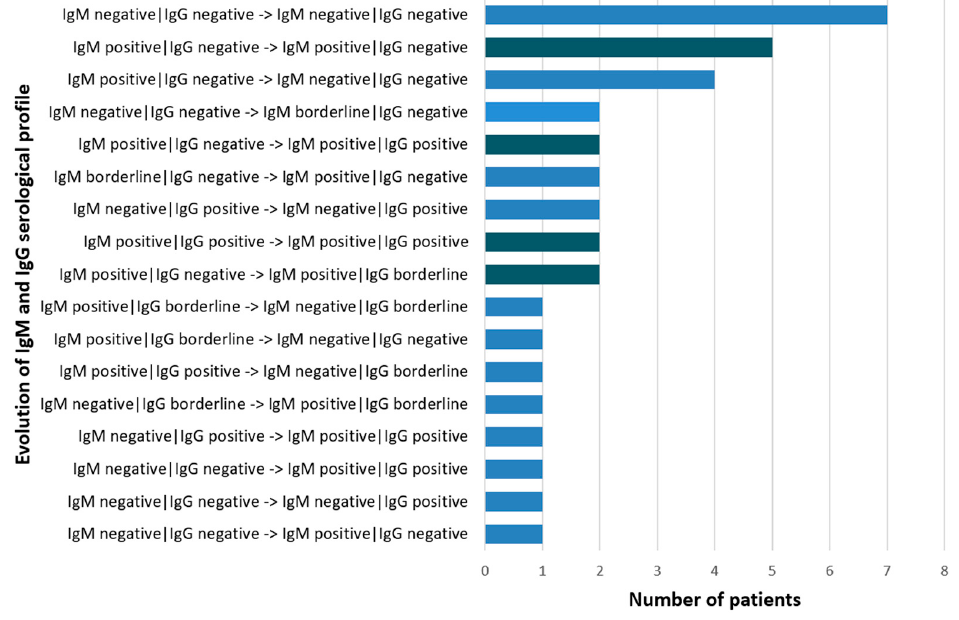
Figure 2. Serological profile of IgM and IgG anti- B. burgdorferi antibodies : IgM/IgG at inclusion –> IgM/IgG at follow-up. The symbol arrow “–>” means evolution from inclusion to follow-up. Persistent IgM positive profiles are represented as bars with darker color.